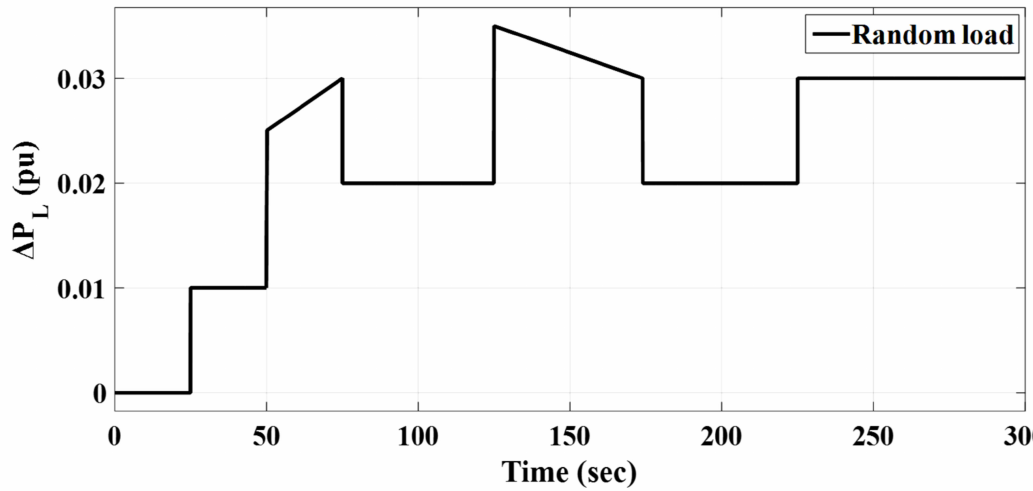
Figure 27. The form of the applied RLV.